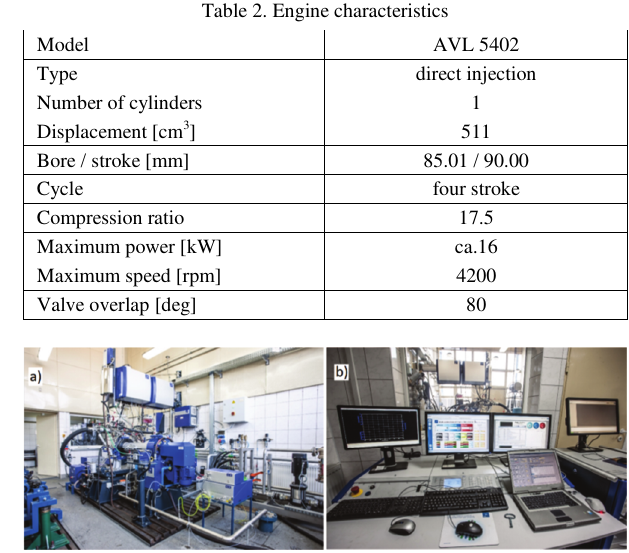
Table 2. Engine characteristics